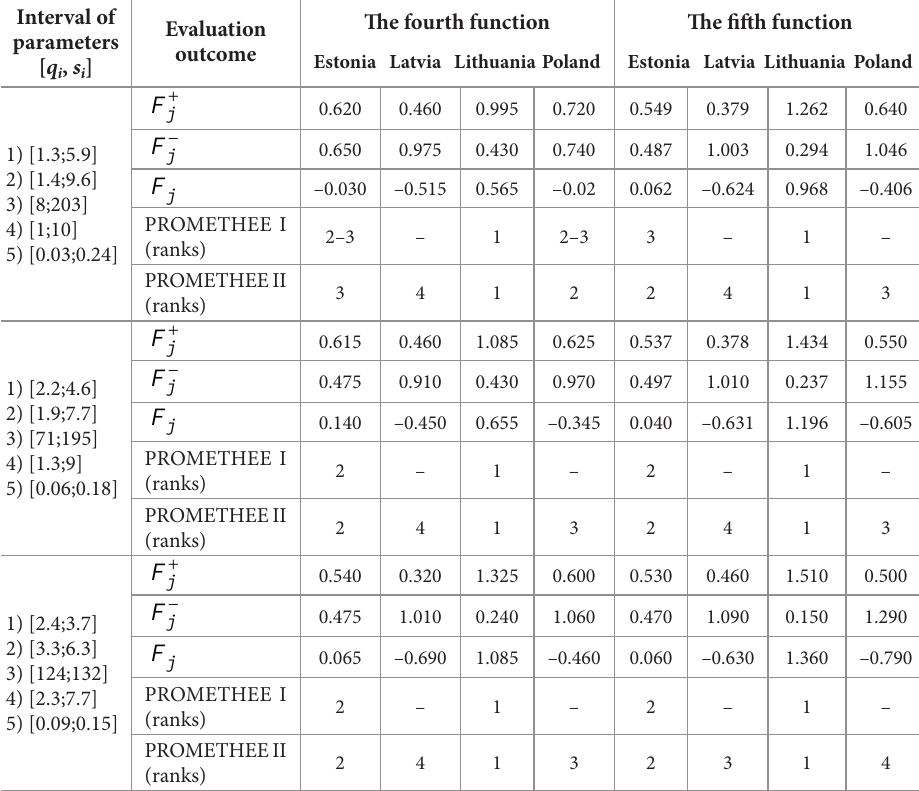
Table 4. Influence of choice of parameters to the evaluation outcome Interval of